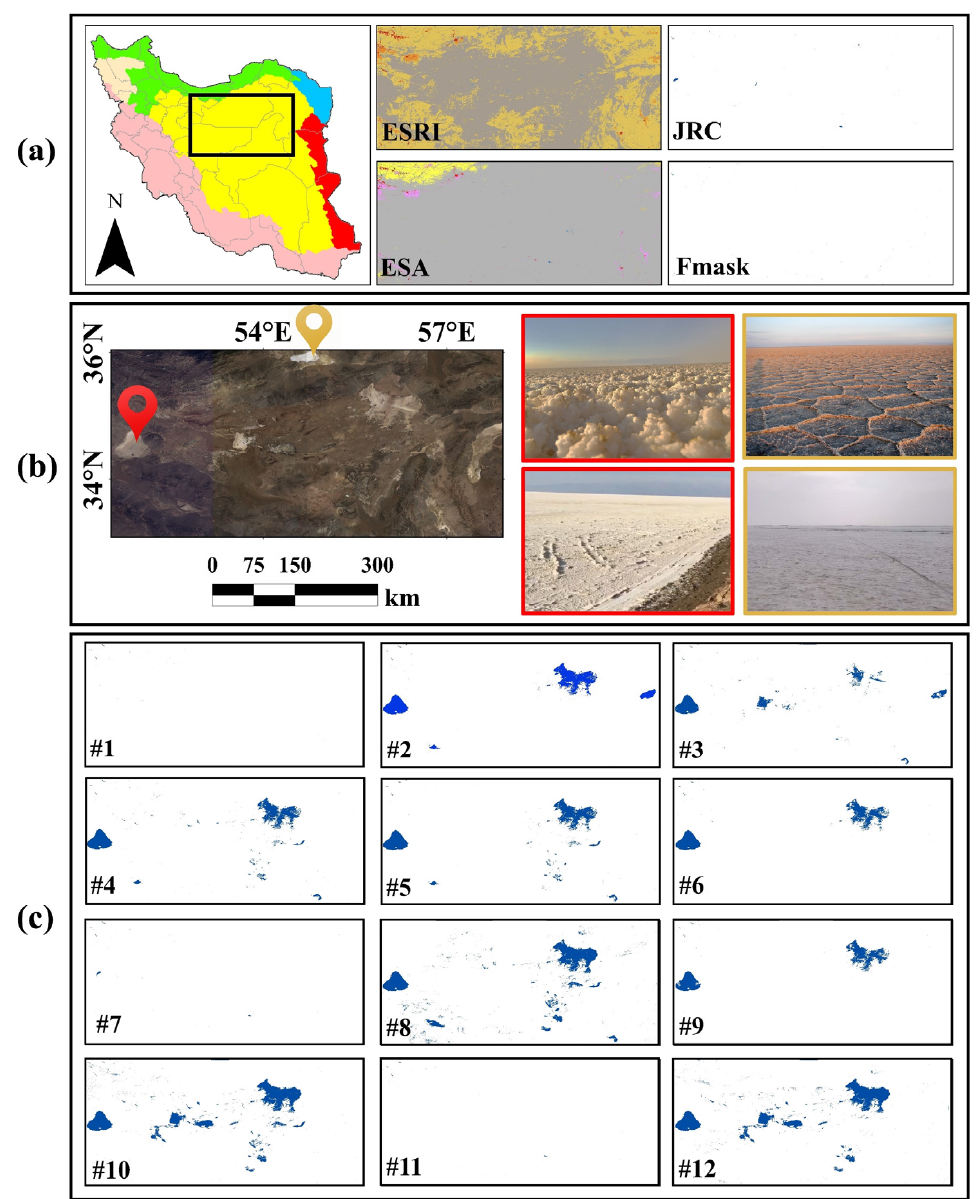
Figure 5. WMR comparison results for the year 2020 in the central regions (central plateau basin) of Iran: ( a ) location of the area and corresponding reference maps; ( b ) Landsat RGB composite of the study site and photos taken during field visits during July–October in 2020, ( c ) results of different WMRs (numbers are based on Table 2).